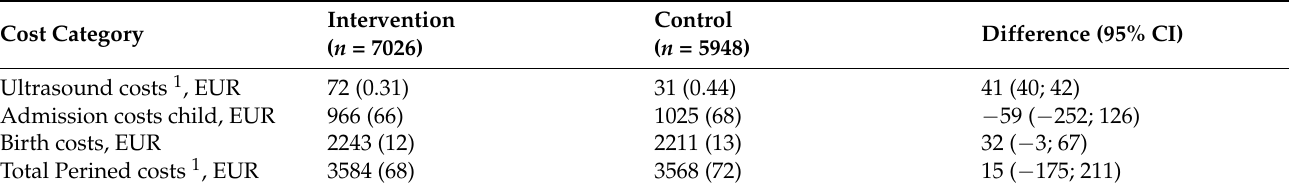
Table 1. Mean costs and cost differences in the Perined sample and ultrasounds.